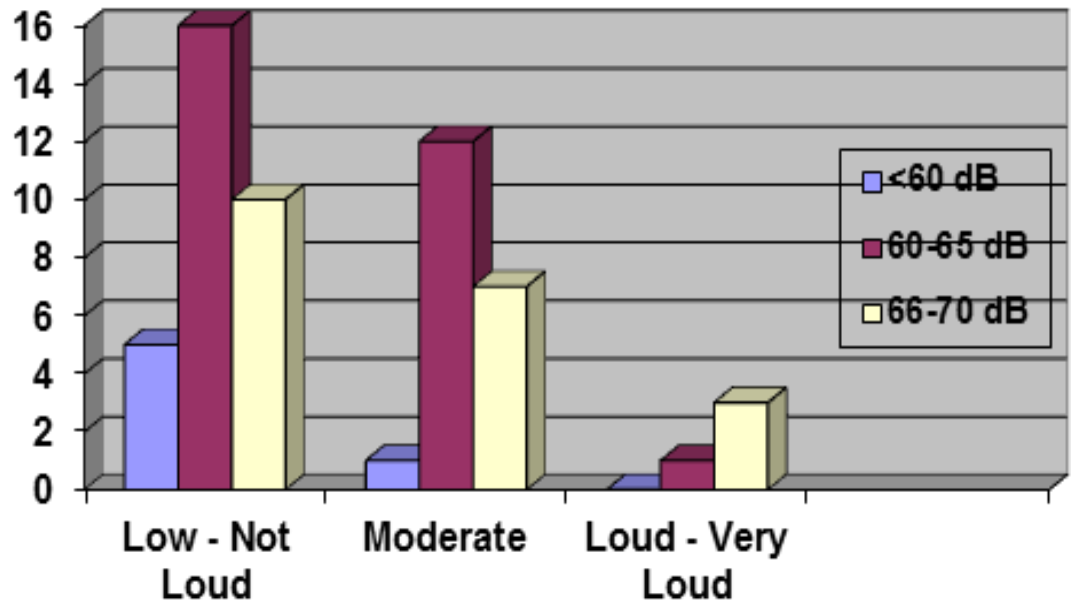
Figure 1 : Actual sound level and number of response (y-axis) compared with subjective nurses reporting of noise level